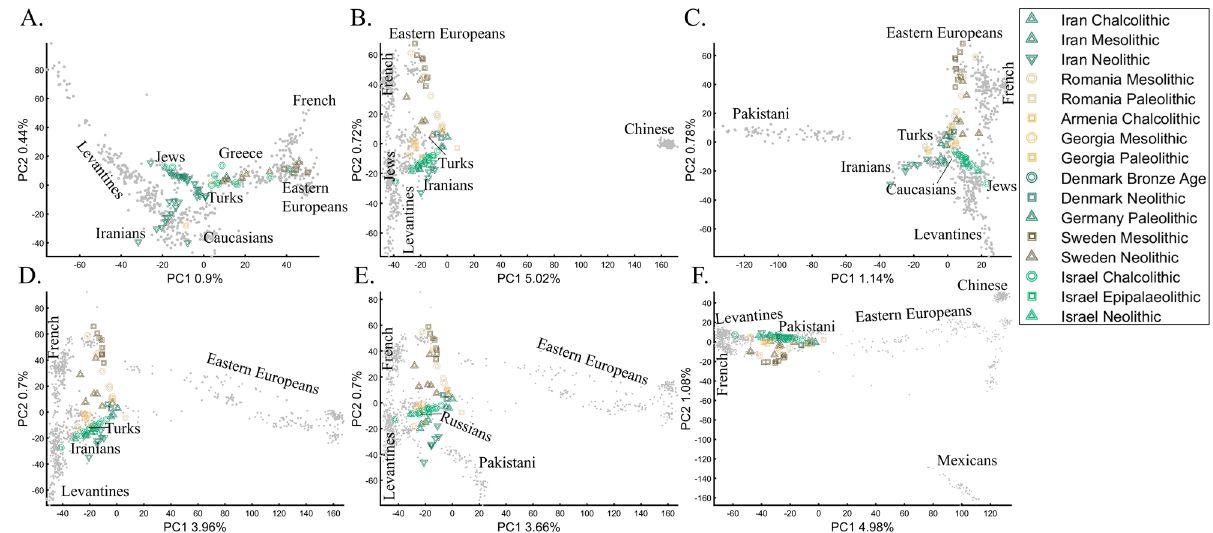
Figure 20. PCA of 65 ancient Palaeolithic, Mesolithic, Chalcolithic, and Neolithic from Iran (12), Israel (16), the Caucasus (7), Romania (10), Scandinavia (15), and Central Europe (5) (colorful shapes) projected onto modern-day populations of various sample sizes (grey dots, black labels). The full population labels are shown in Supplementary Fig. S8. In addition to the modern-day populations used in ( A ), the following subfigures also include ( B ) Han Chinese, ( C ) Pakistani (Punjabi), ( D ) additional Russians, ( E ) Pakistani (Punjabi) and additional Russians, and ( F ) Pakistani (Punjabi), additional Russians, Han Chinese, and Mexicans. The ancient samples remained the same in all the analyses. In each plot ( A – F ), the ancient Levantines cluster with different modern-day